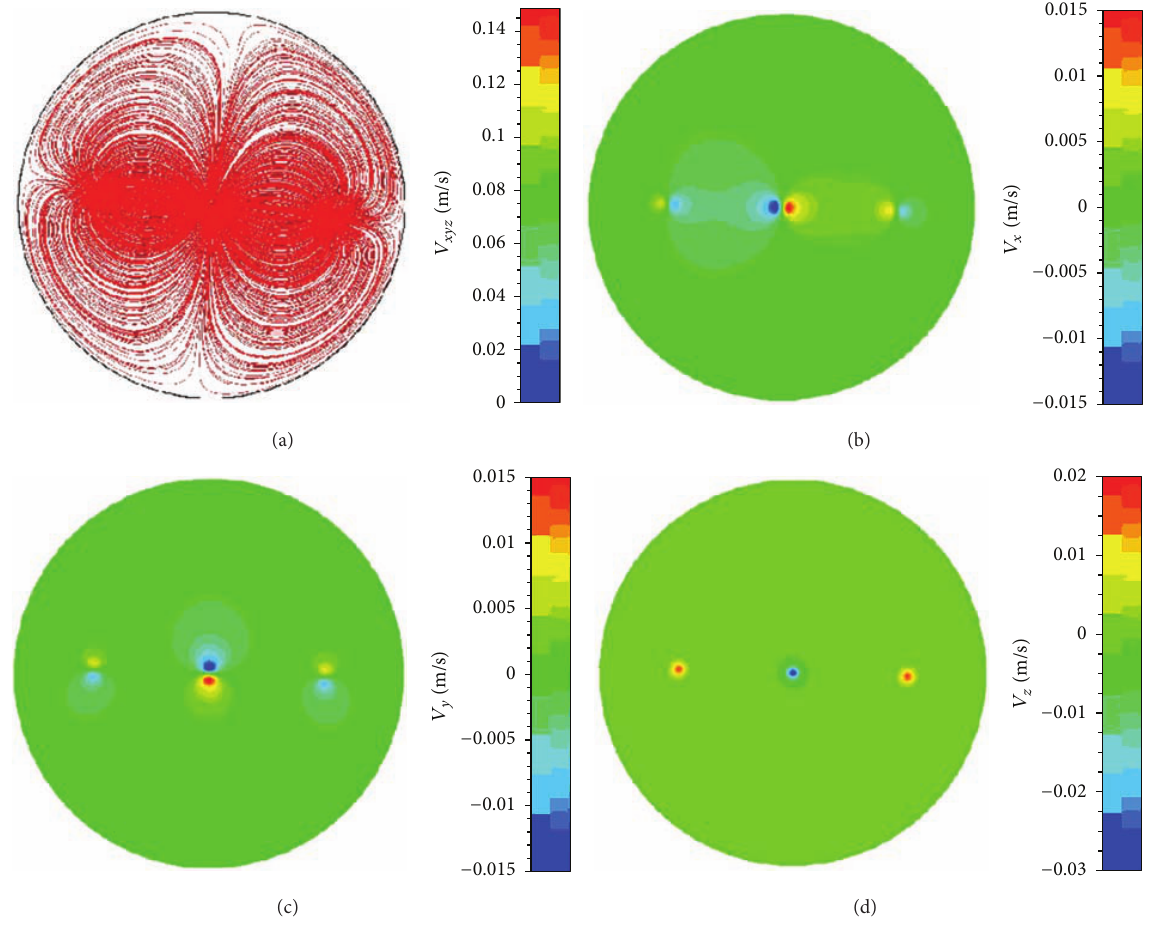
Figure 11: The simulation analysis when the flow rate is 200 mg/s. (a) Streamline distribution, (b) velocity distribution in 𝑥 direction, (c) velocity distribution in 𝑦 direction, (d) velocity distribution in 𝑧